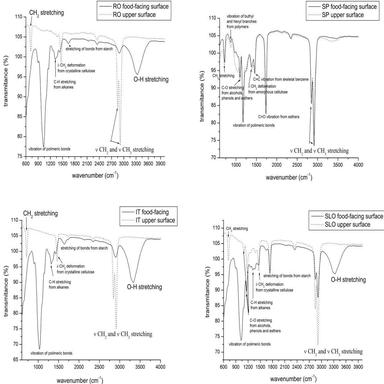
FTIR spectra of the RO paper a), SP paper b), IT paper c) and SLO paper d).